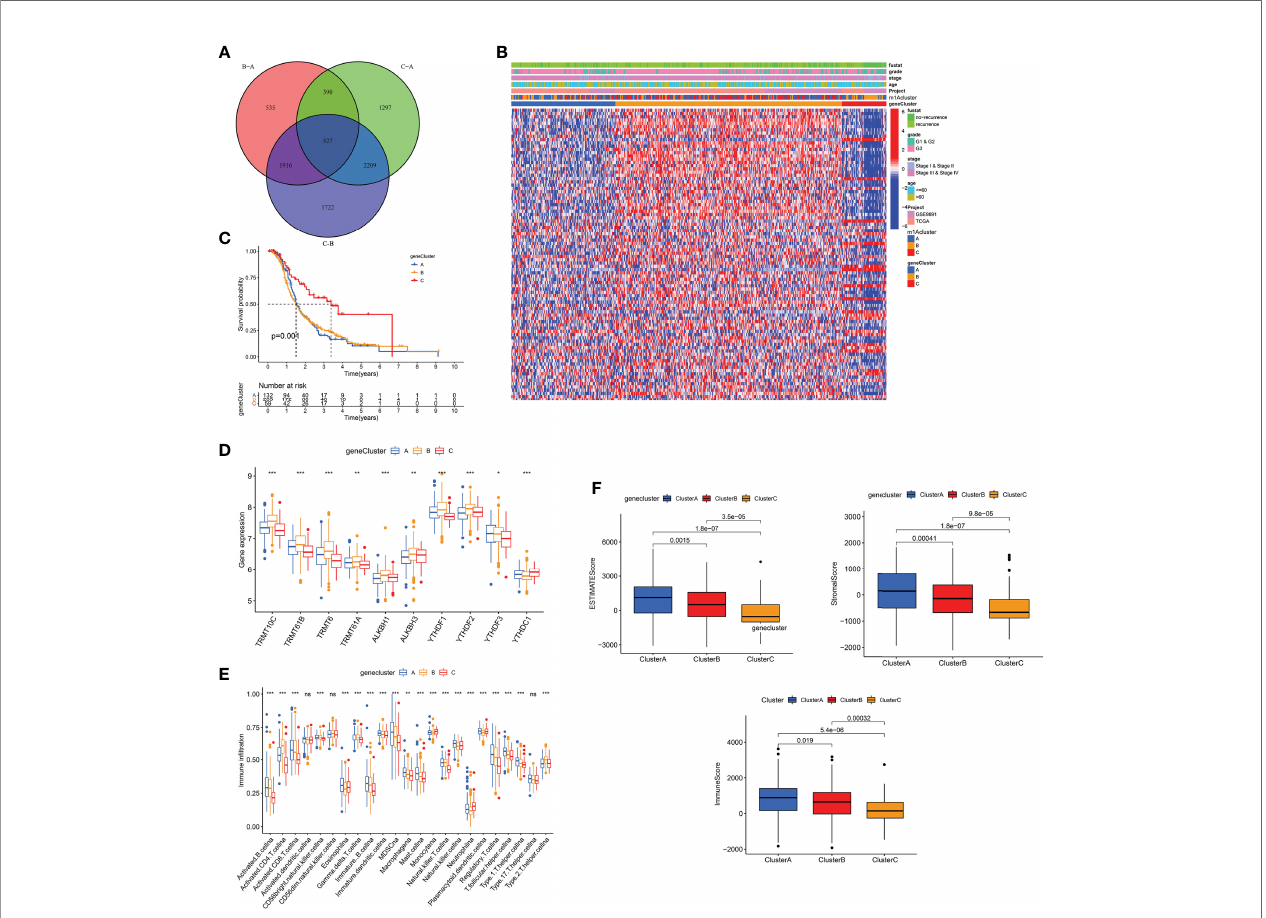
FIGURE 4 | The m1A gene clusters in OC and biological characteristics of m1A gene subtypes. (A) 527 m1A phenotype-related genes shown in venn diagram. (B) Unsupervised clustering of overlapping m1A phenotype-related genes in TCGA and GEO cohorts to classify patients into different genomic subtypes, termed as m1A gene cluster A-C, respectively. The gene clusters, m1A clusters, tumor stage, grade, survival status and age were used as patient annotations. (C) Kaplan- Meier curves indicated m1A modi fi cation genomic phenotypes were markedly related to overall survival of OC patients. (D) The expression of 10 m1A regulators in three m1A gene clusters. (E) The abundance of each TME in fi ltrating cell in three m1A gene clusters. (F) The box plot indicated difference in immune scores, stromal scores and estimate score between three m1A gene clusters. *P < 0.05; **P < 0.01; ***P < 0.001. ns, not signi fi